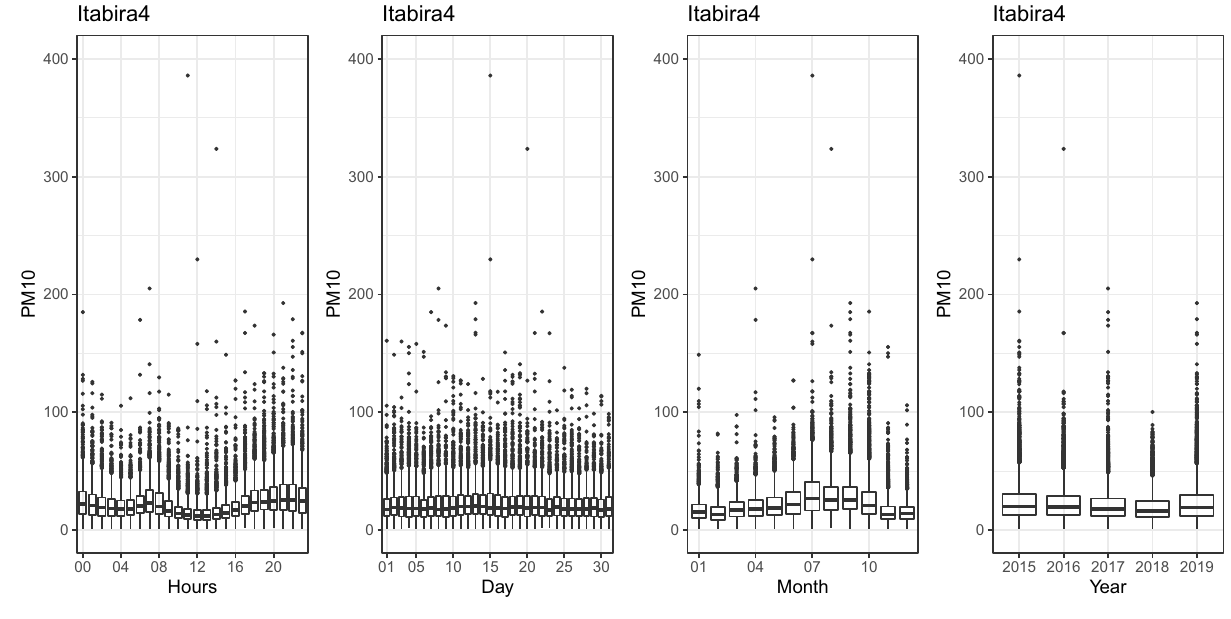
Figure 4. Hourly, daily, monthly and yearly boxplots for the monitoring station with the lowest average of PM 10 concentration (Itabira4), respectively.